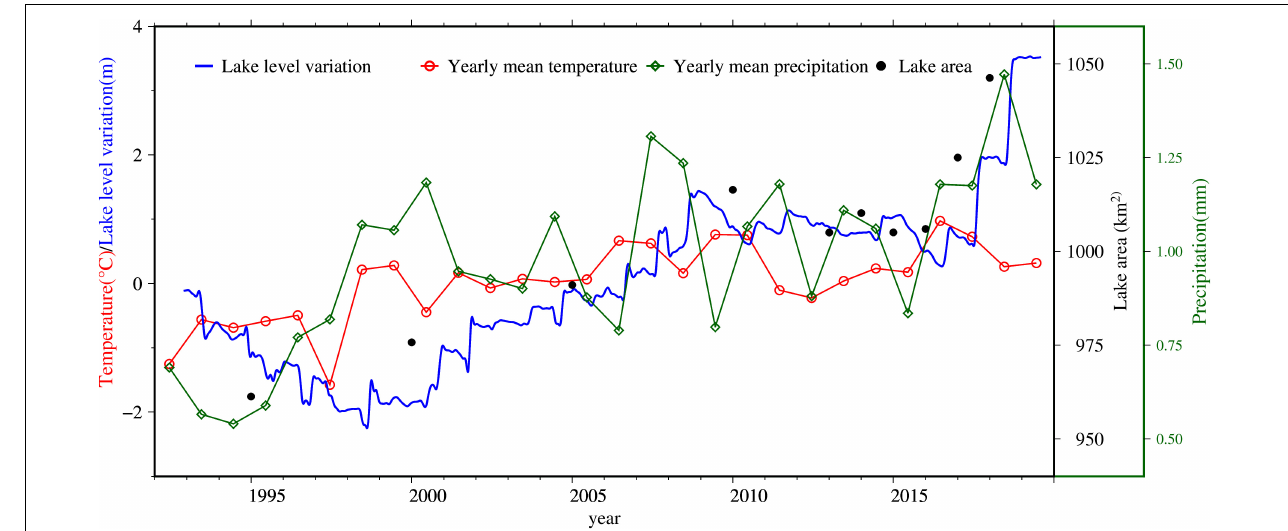
FIGURE 11 | Variation of temperature, precipitation, lake level and area in Zhari